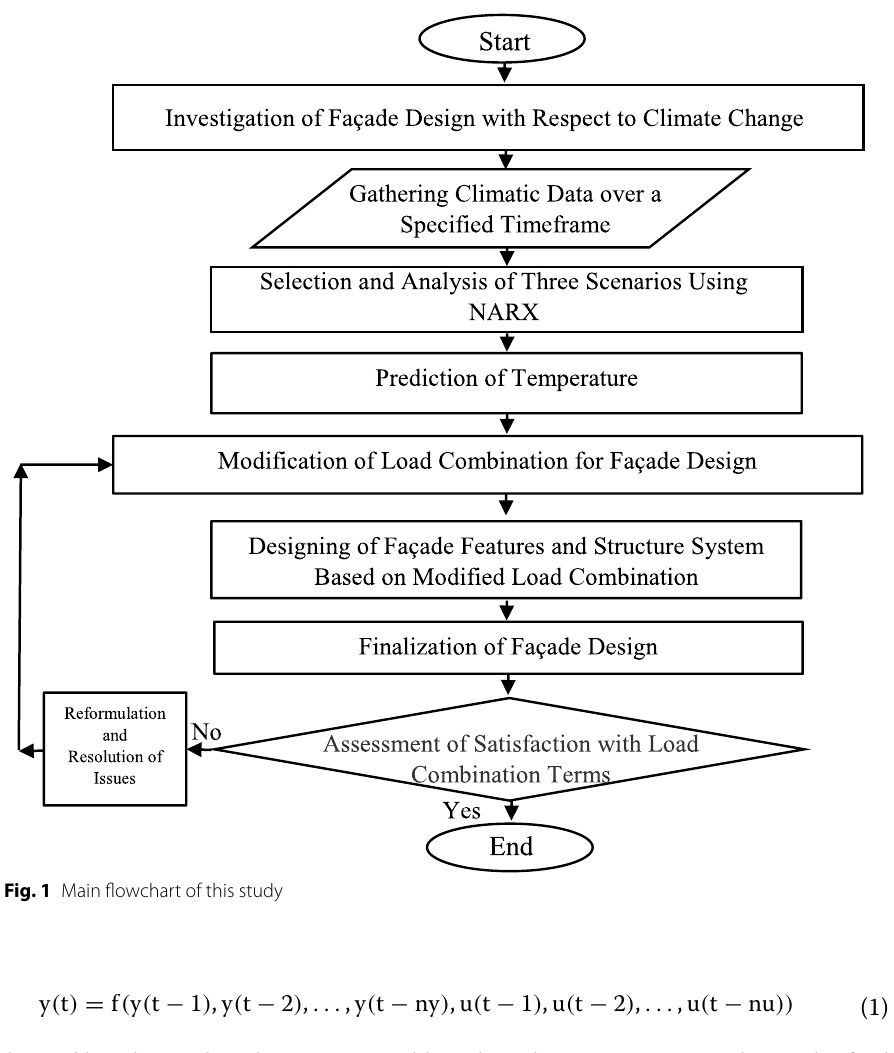
Fig. 1 Main flowchart of this